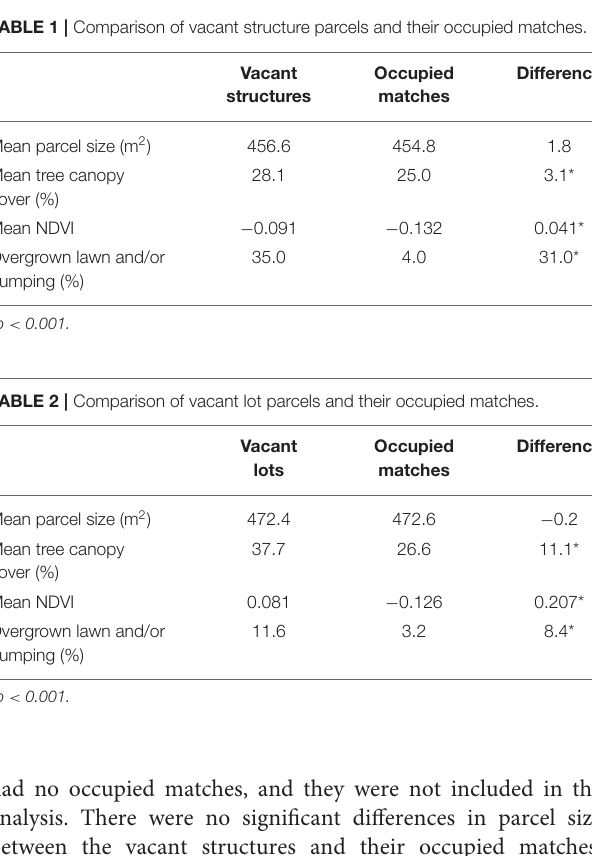
TABLE 1 | Comparison of vacant structure parcels and their occupied matches.